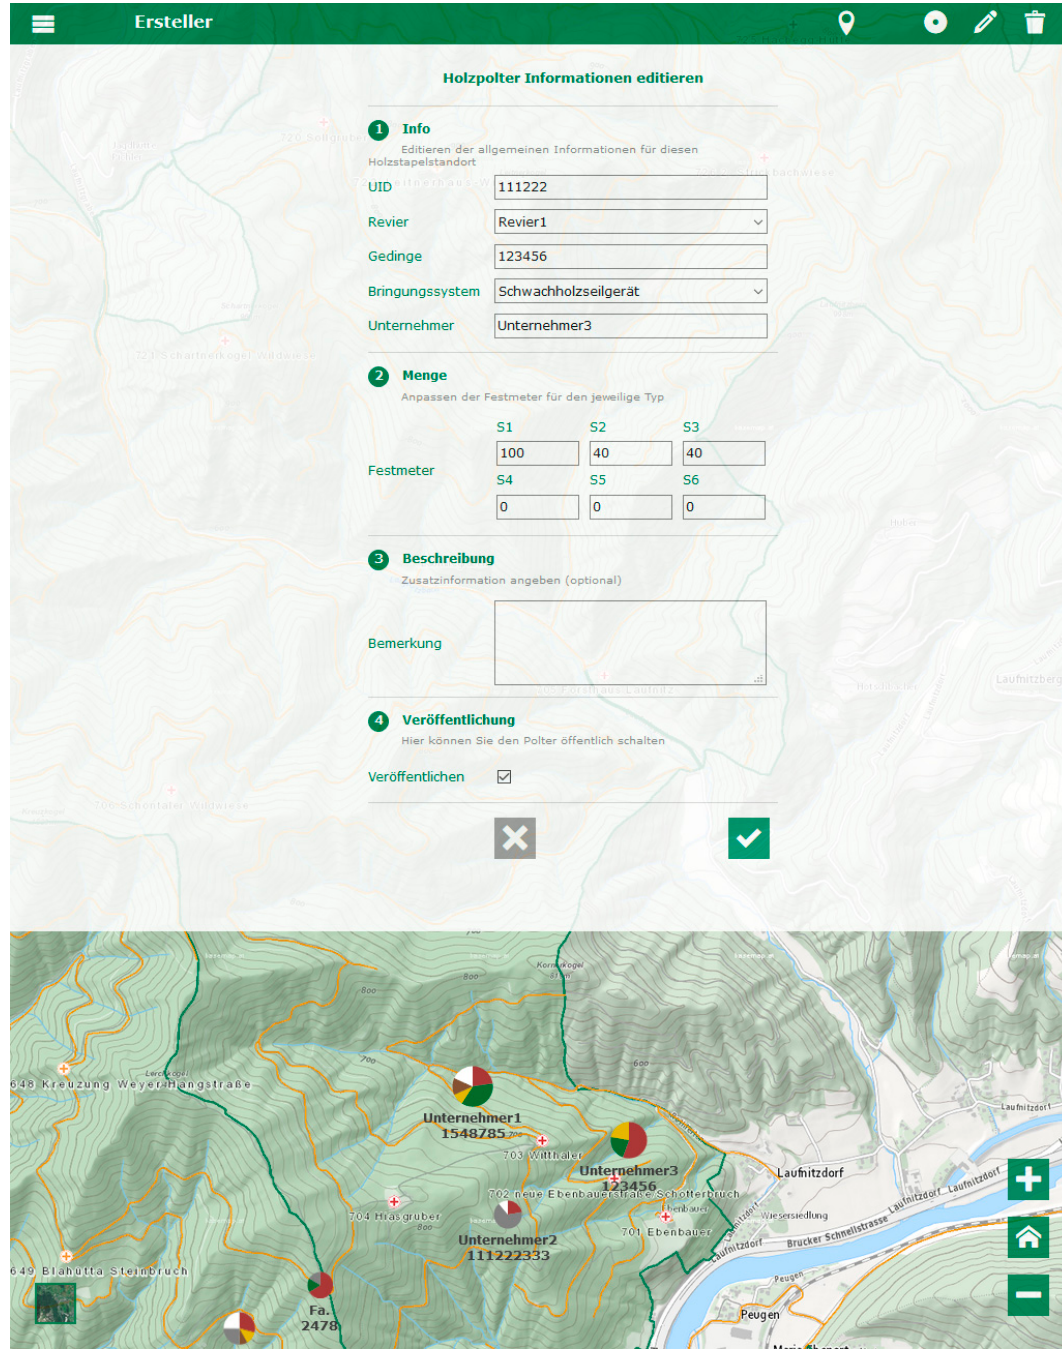
Figure 7. The “ Harvester/forwarder app ” for managing woodpile locations is one of the five web 419 Figure 7. The “Harvester/forwarder app” for managing woodpile locations is one of the five web mapping apps of the role-tailored map dashboard. 420 mapping apps of the role-tailored map